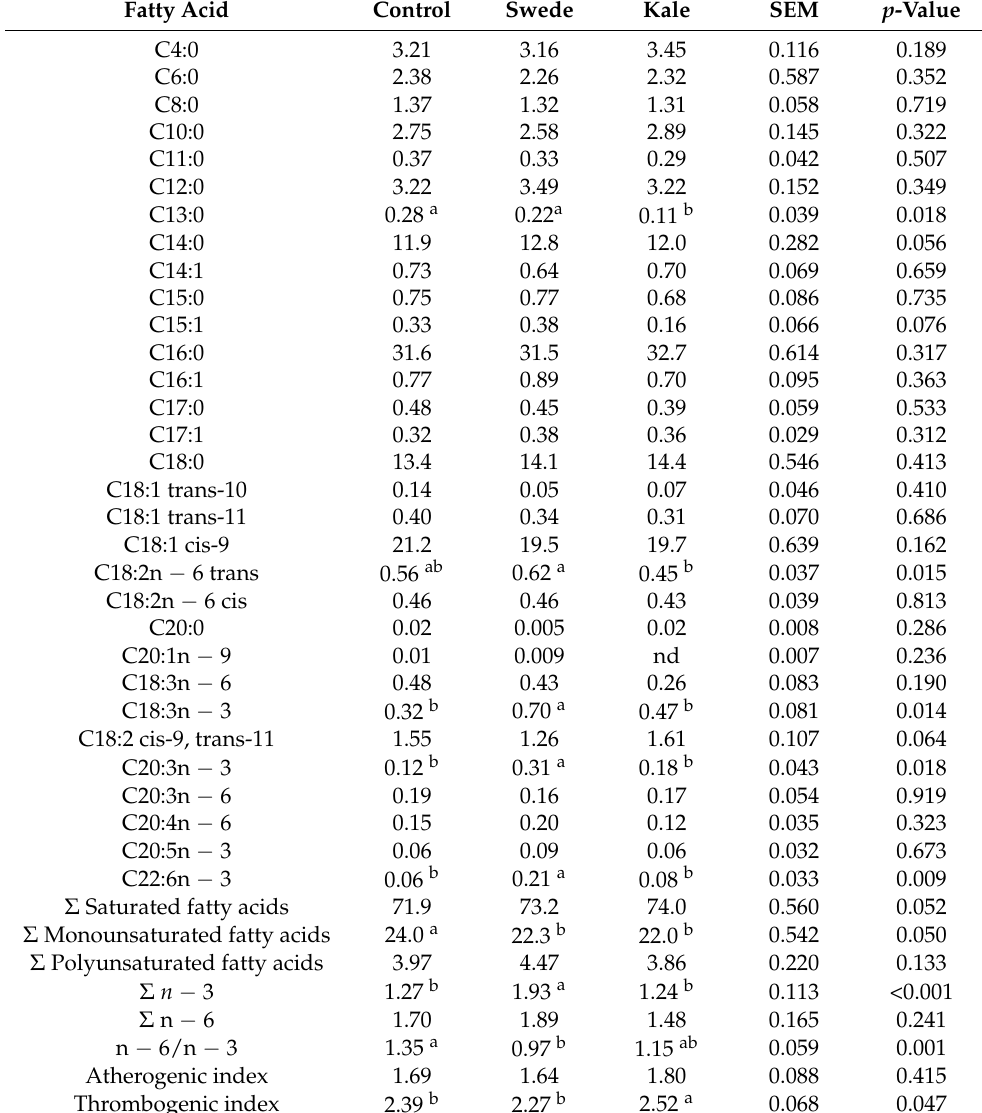
Table 3. Fatty acid profile (g/100 g of total fatty acids) of milk from early lactation dairy cows fed control or supplemented with swedes or